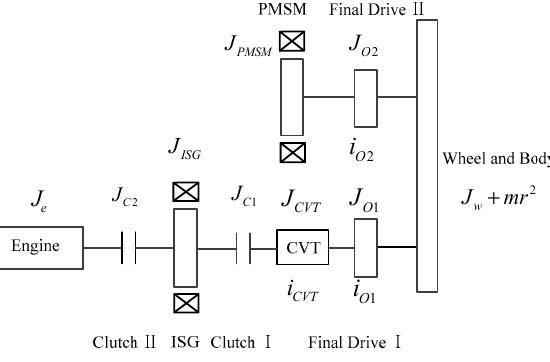
Figure 5. Equivalent diagram of the system model.